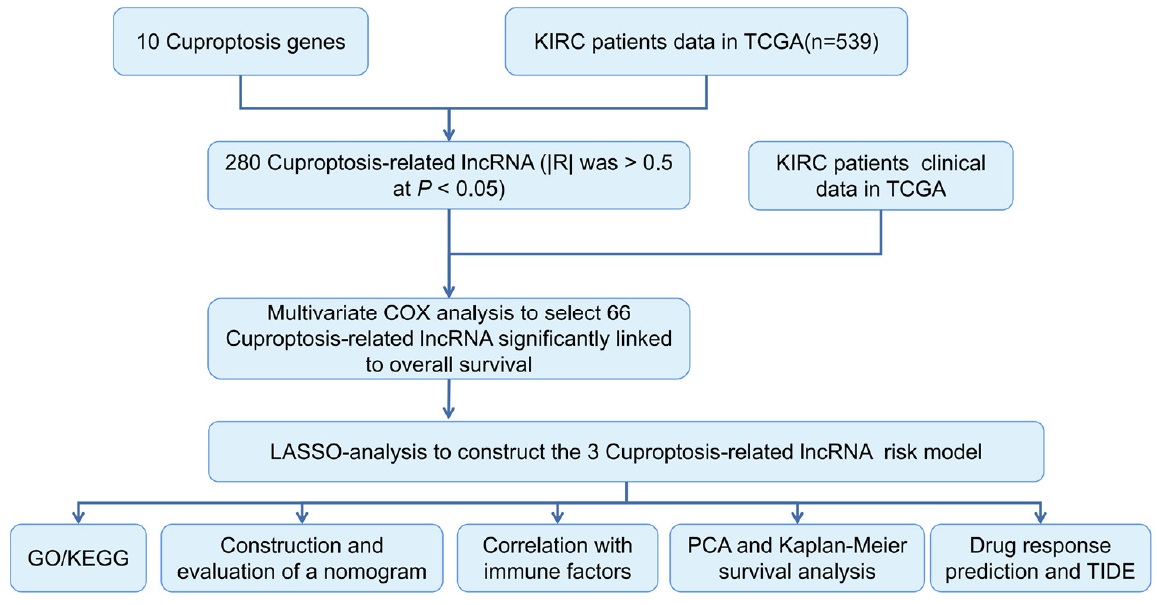
Figure 1. Research process flowchart.